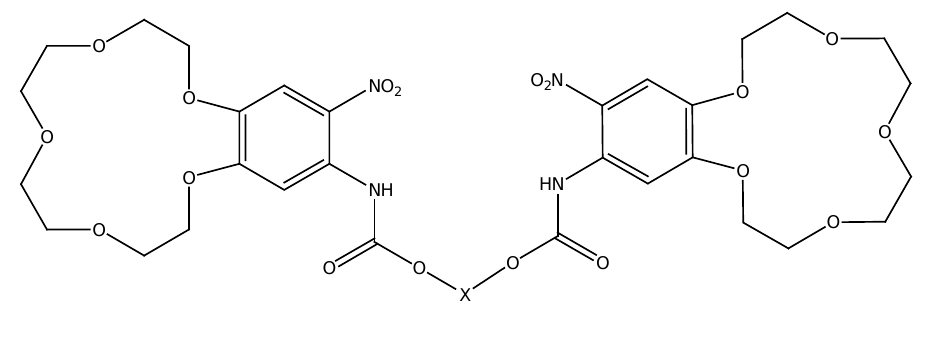
Figure 34. Covalently immobilized crown